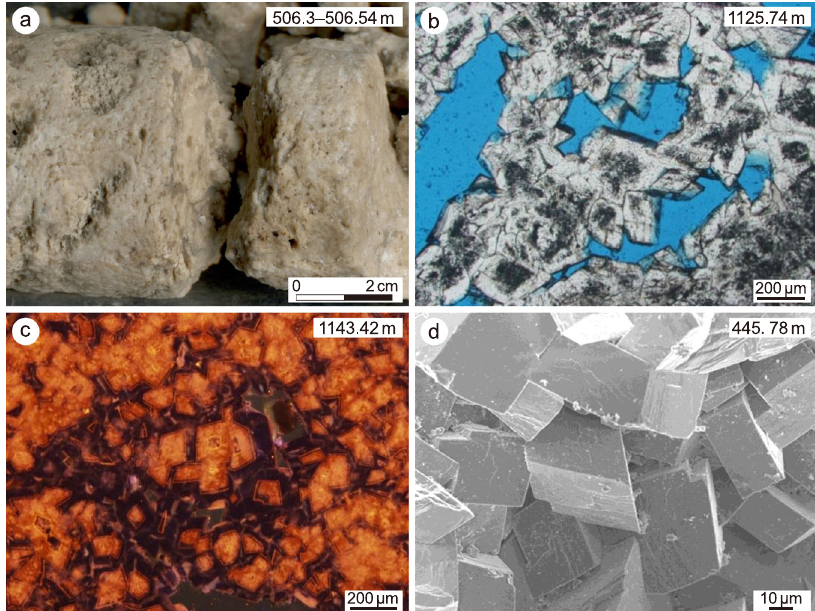
Fig. 2 Petrographic images of dolostones. a Hand specimens, depth of 506.3 – 506.54 m. b Dolomite rhombs with cloudy cores and clear rims, 1125.74 m, plane-polarized light, stained section. c Cathodoluminescence (CL) image showing orange cores and dark rims, 1143.42 m. d SEM photograph of euhedral dolomite rhombs,